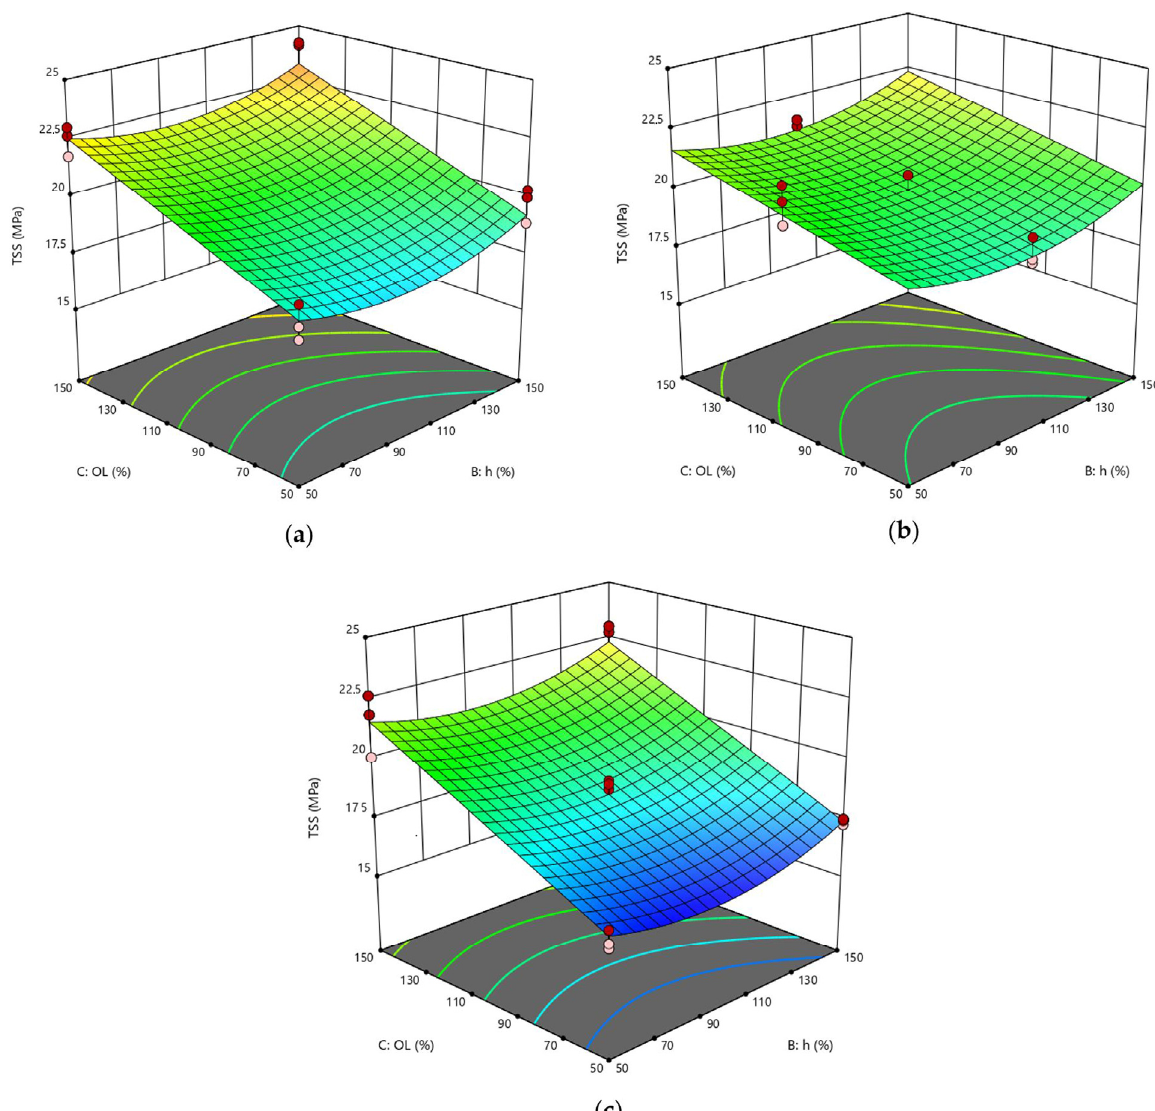
Figure 10. RSD 2: ( a ) P = 20 W; ( b ) P = 35 W; ( c ) P = 50 W.